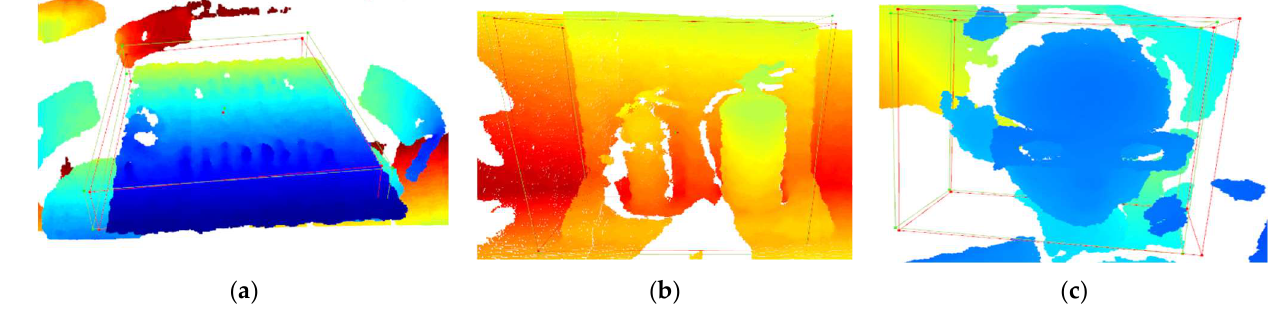
Table 1. Loss of object pose estimation.